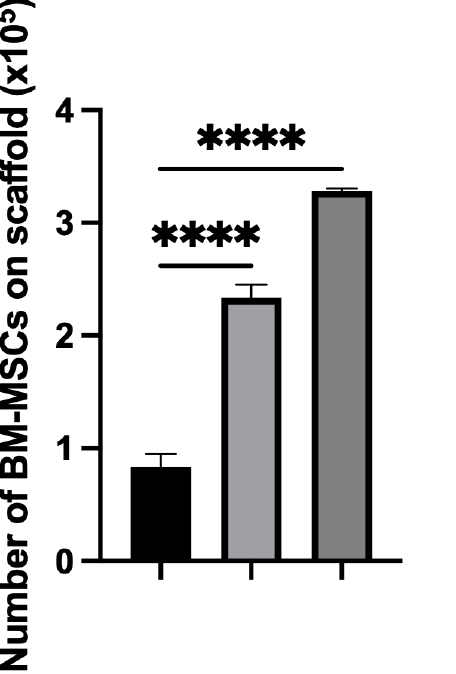
Figure 5. Number of BM-MSCs on an nHAP- coated PCL/HAP/β -TCP scaffold 3 h post-seeding